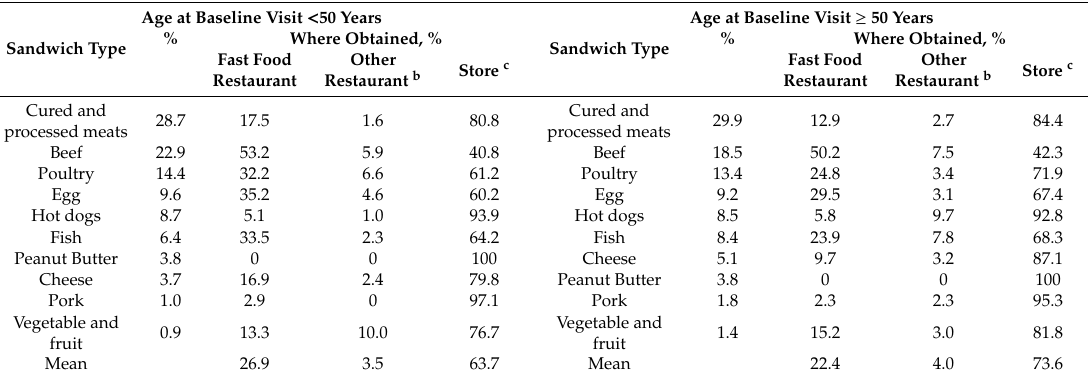
Table 4. Type of sandwich reported consumed and where sandwich obtained by HANDLS study participants by age ( n = 1213) a